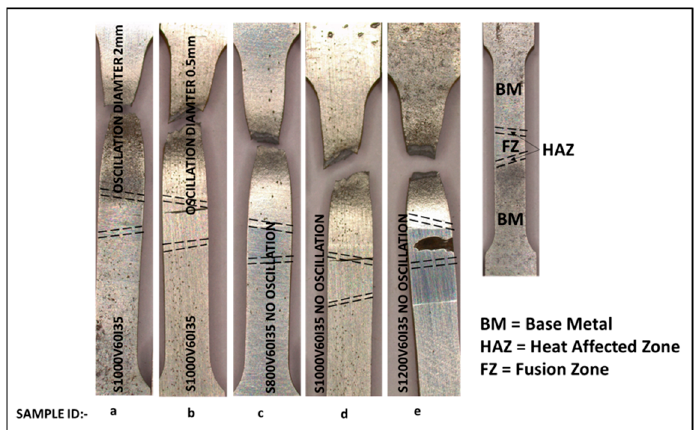
Figure 10. Tensile sample after the test for different sample conditions ( a ) S1000V60I35 OD 2 mm, ( b ) S1000V60I35 OD 0.5 mm ( c ) S800V60I35 WO, ( d ) S1000V60I35 WO and ( e ) S1200V60I35 .